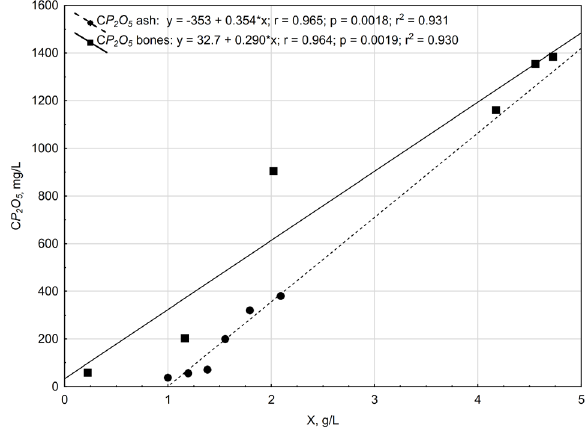
Figure 3: The correlation between the biomass concentration (X, g/L) and the concentration of P